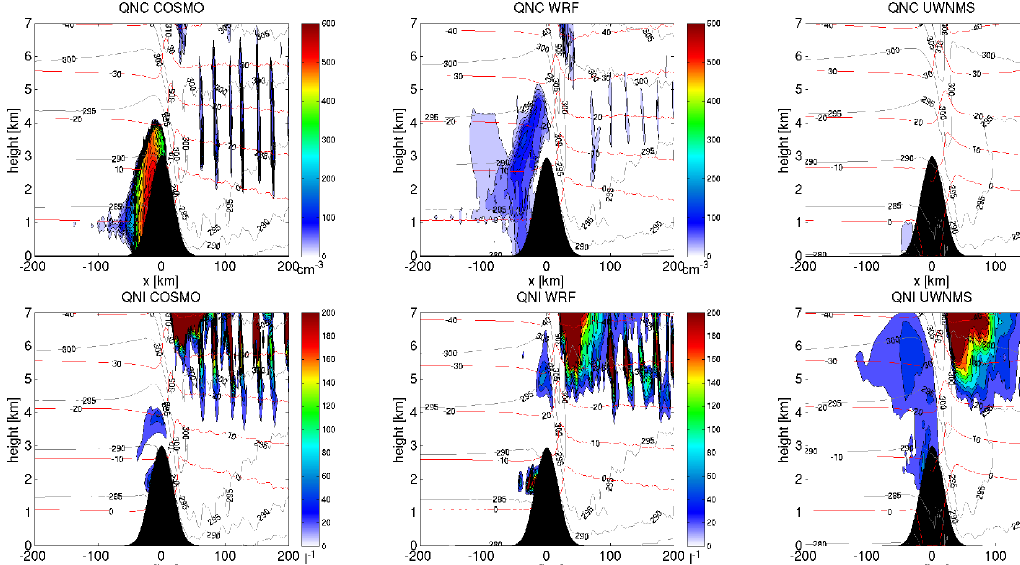
Fig. 16. Same as Fig. 7 but for simulation SIM 3 PC.